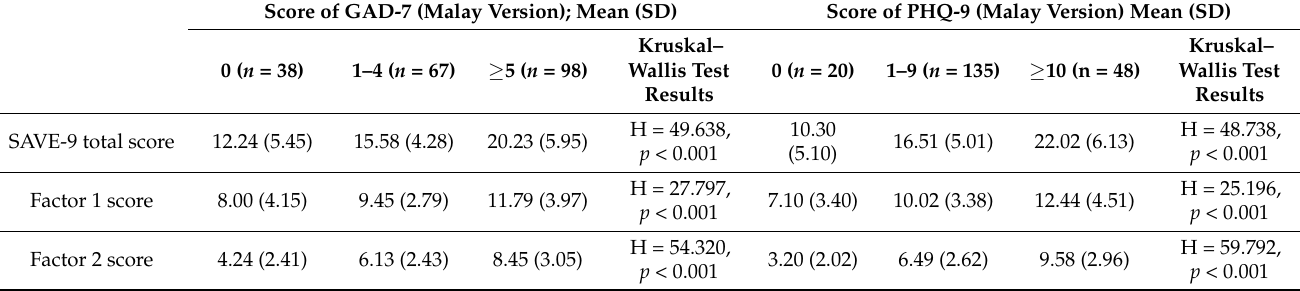
Table 6. SAVE-9 Malay version, Factor 1, and Factor 2 scores among groups based on GAD-7 and PHQ-9